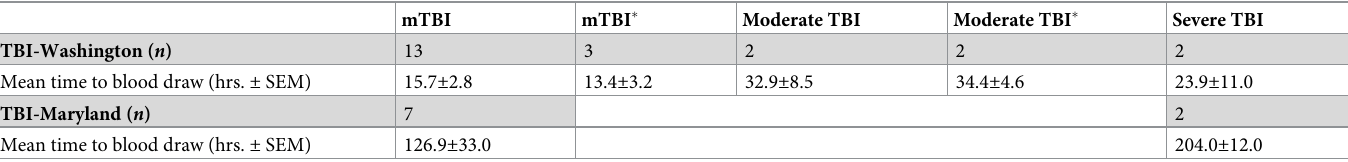
Table 2. External validation cohort—TBI severity and time to blood